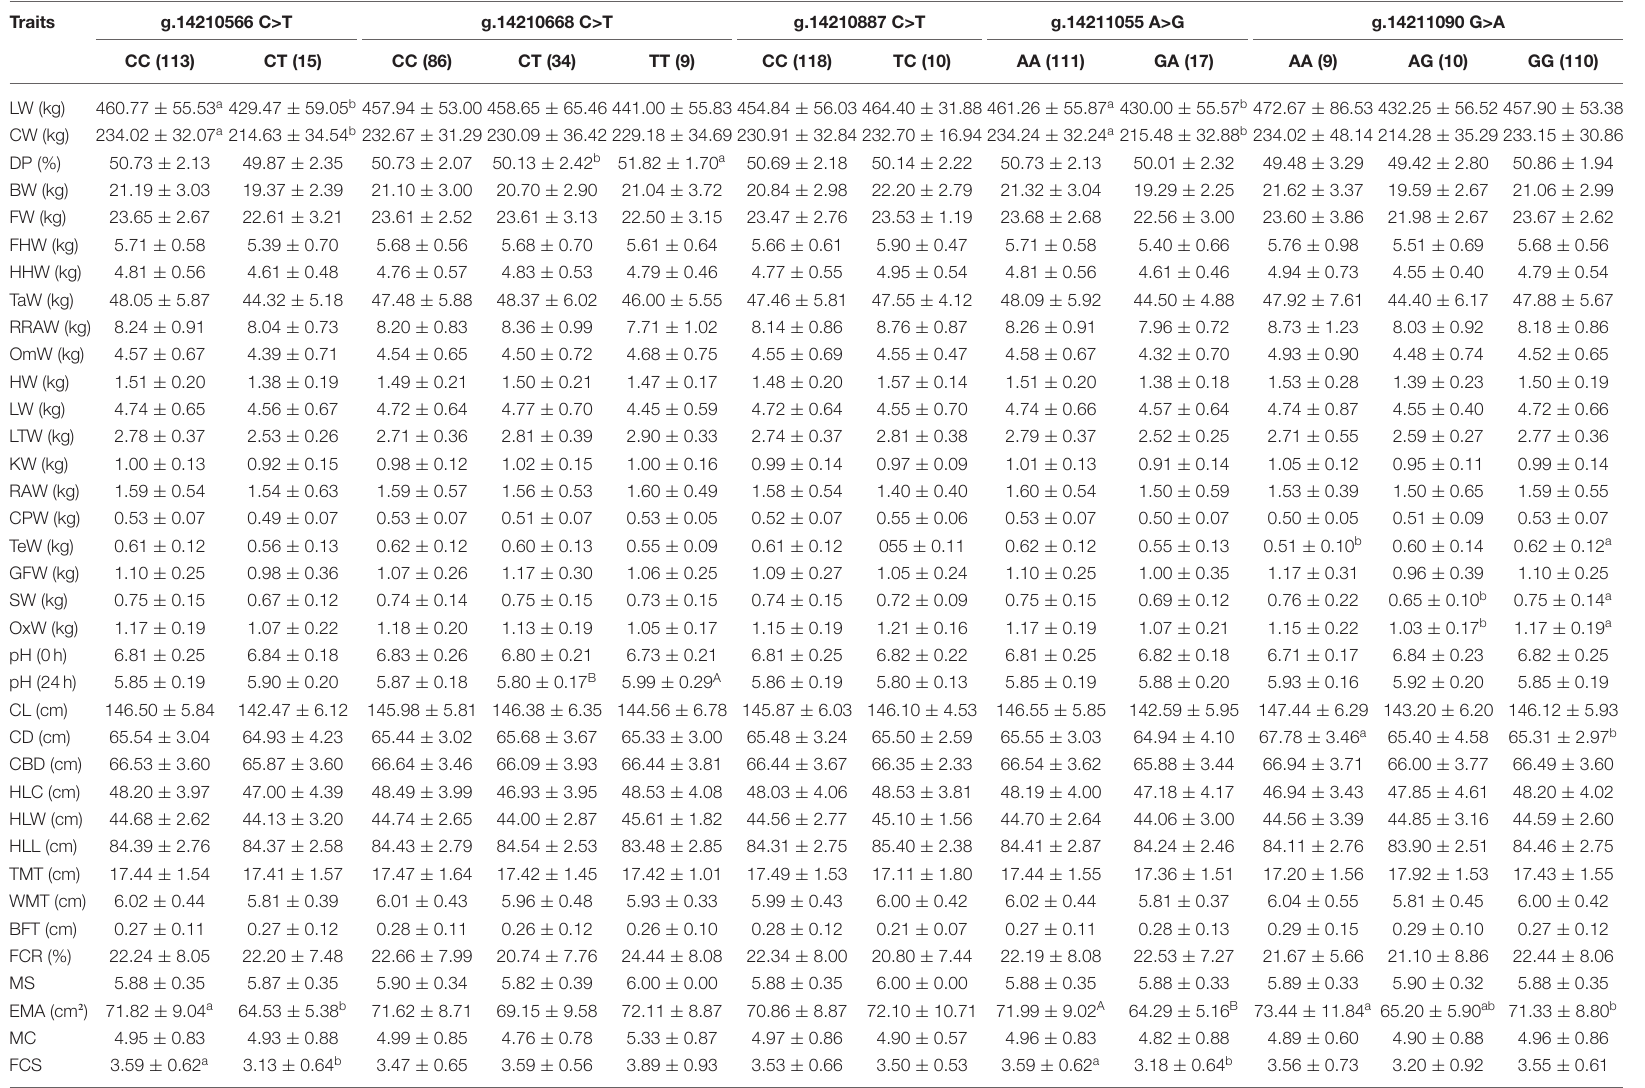
TABLE 2 | Association analysis of five SNPs in the second exon of ACSF3 gene and economic traits in Chinese Simmental Cattle.